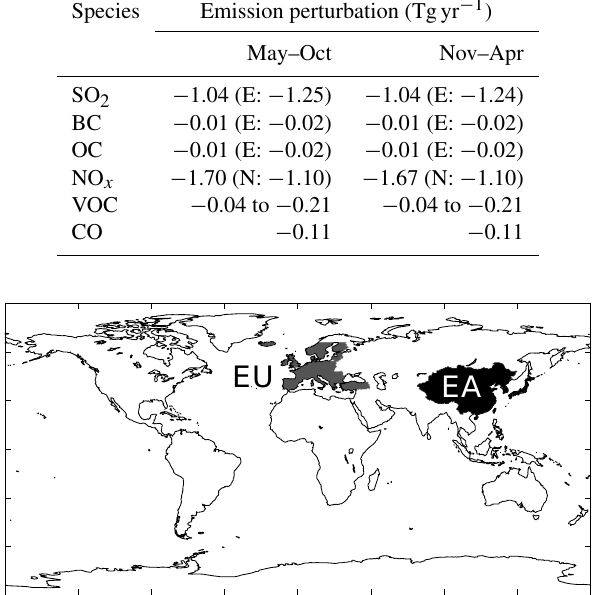
Figure 1. HTAP tier-1 regions used in the ECLIPSE specific radia- tive forcing matrix. EU stands for Europe and EA for East Asia.